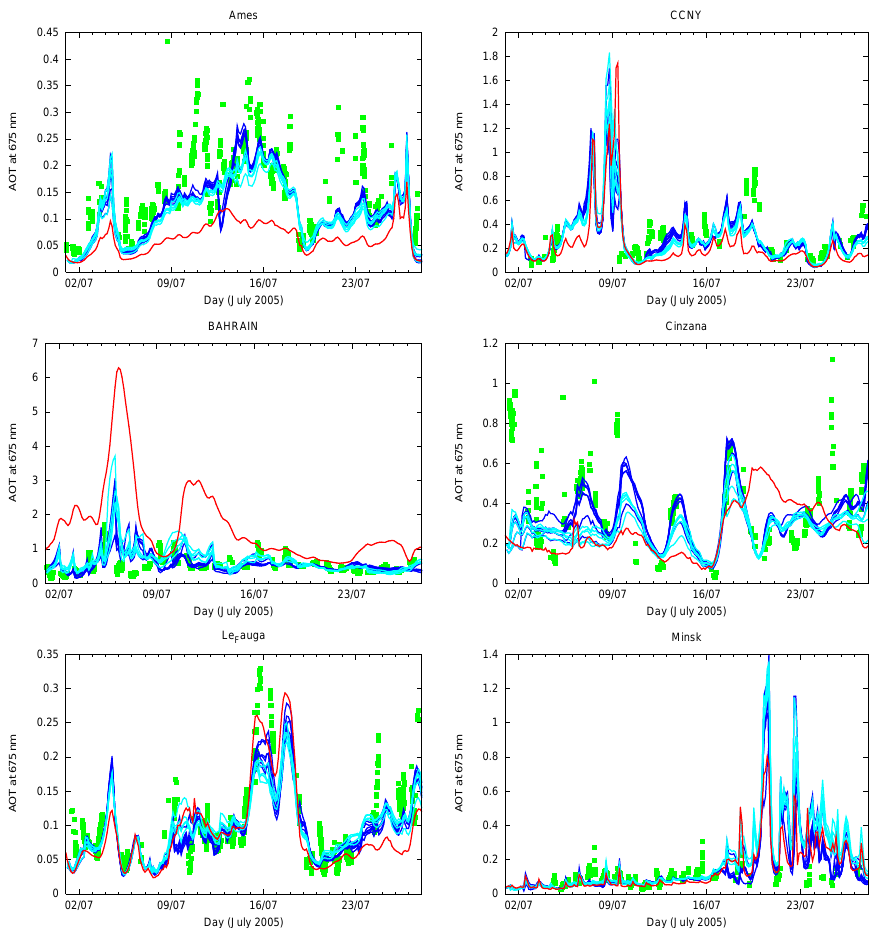
Fig. 12. AOT and AAE at selected AERONET sites for various experiments. In red the standard SPRINTARS simulation. In dark blue, experiments for n reg = 128 , in light blue, experiments for n reg = 1 . Also shown are actual observations (green squares).